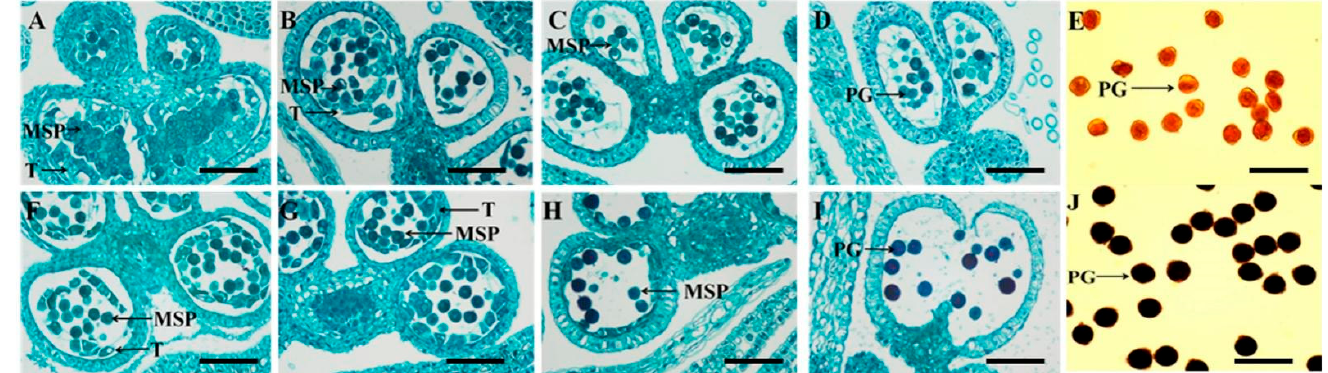
Figure 1. Microscopic observations of anthers from the soybean cytoplasmic male sterility (CMS) line SXCMS5A and its maintainer SXCMS5B. ( A – D ) Transverse sections of sterile anthers; abnormal tapetum and abnormal anthers developed in SXCMS5A. ( E ) Mature pollen grains stained by I 2 -KI in SXCMS5A. ( F – I ) Transverse sections of fertile anthers; normal tapetum and normal anthers developed in SXCMS5B. ( J ) Mature pollen grains stained by I 2 -KI in SXCMS5B. MSP, microspore; T, tapetum; PG, pollen grain; Bars = 20 μ m.